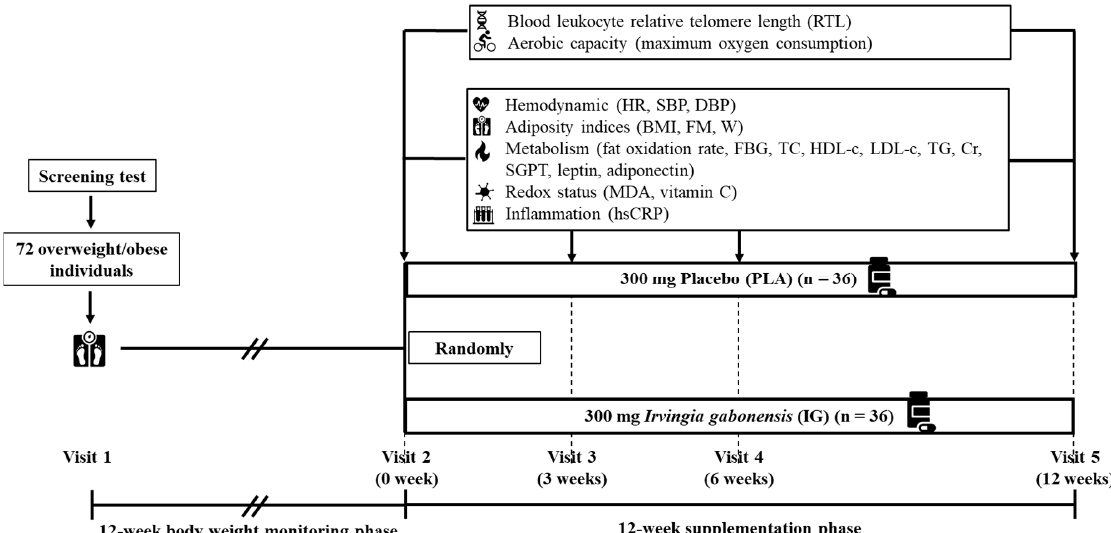
Figure 1. Protocol of this study. Abbreviations: HR, heart rate; SBP, systolic blood pressure; DBP, diastolic blood pressure; BMI, body mass index; FM, fat mass; W, waist circumference; FBG, fasting blood glucose; TC, total cholesterol; HDL-c, high-density lipoprotein cholesterol; LDL-c, low-density lipoprotein cholesterol; TG, triacylglycerol; Cr, creatinine; SGPT, serum glutamate pyruvate transaminase; MDA, malondialdehyde; hsCRP, high-sensitivity C-reactive protein.